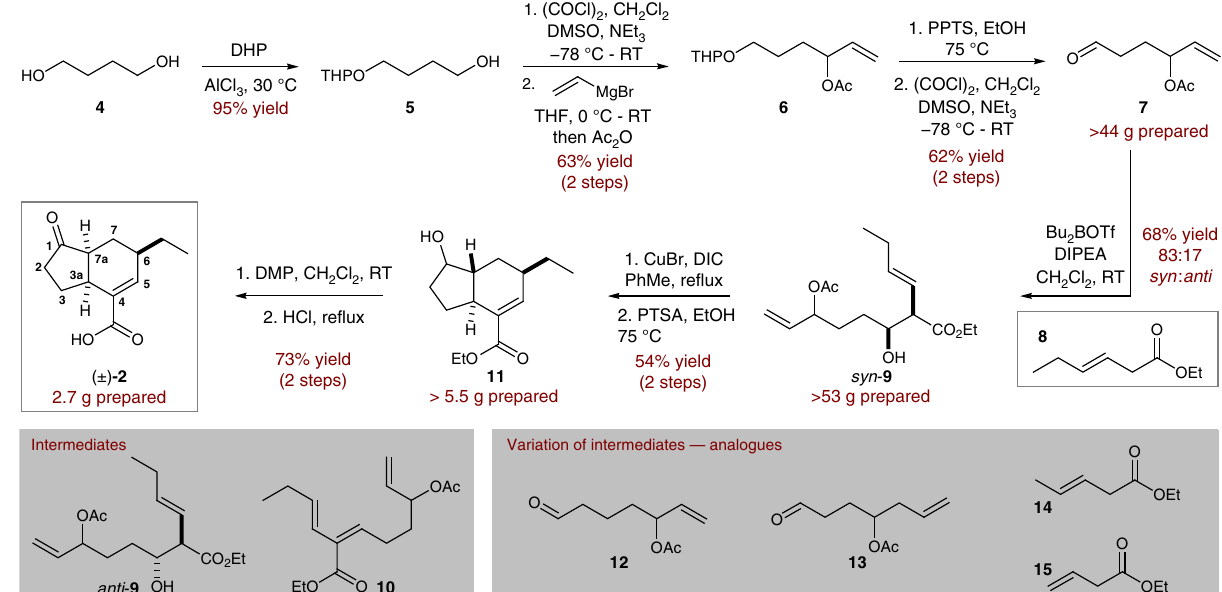
ring was achieved through use of homologated aldehyde aldol partners ( 7 → 12/13 ), leading to regioisomeric and ring expanded (decalin) cores.